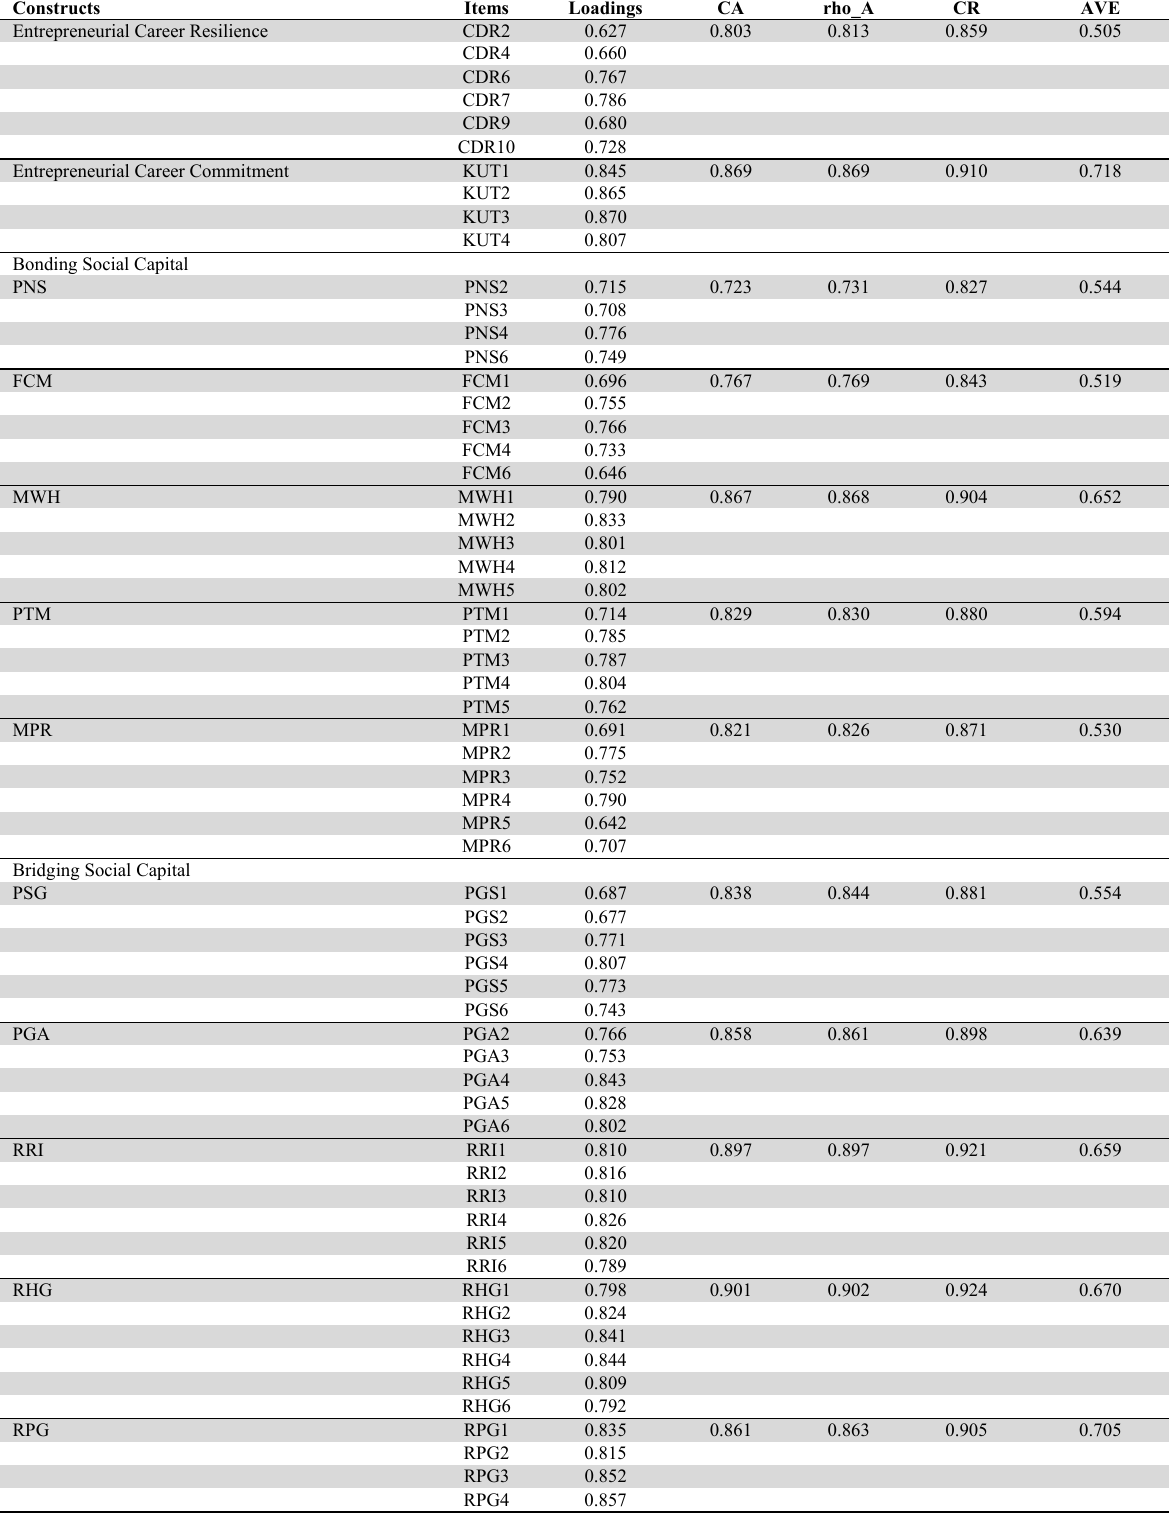
Loadings, CR and AVE